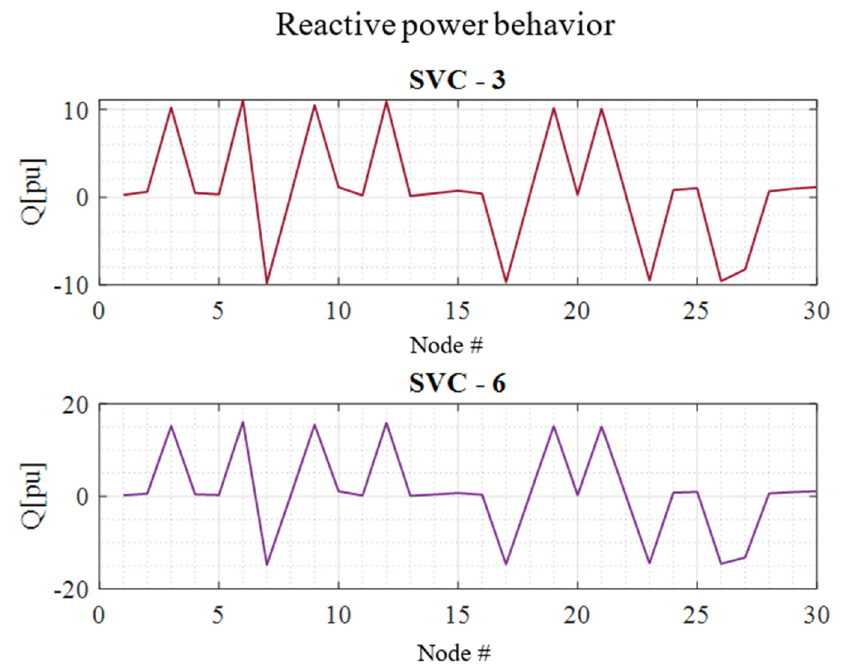
Figure 19. Profile of nodal reactive power in the IEEE 30-bus test system: SVC 3 and 6.